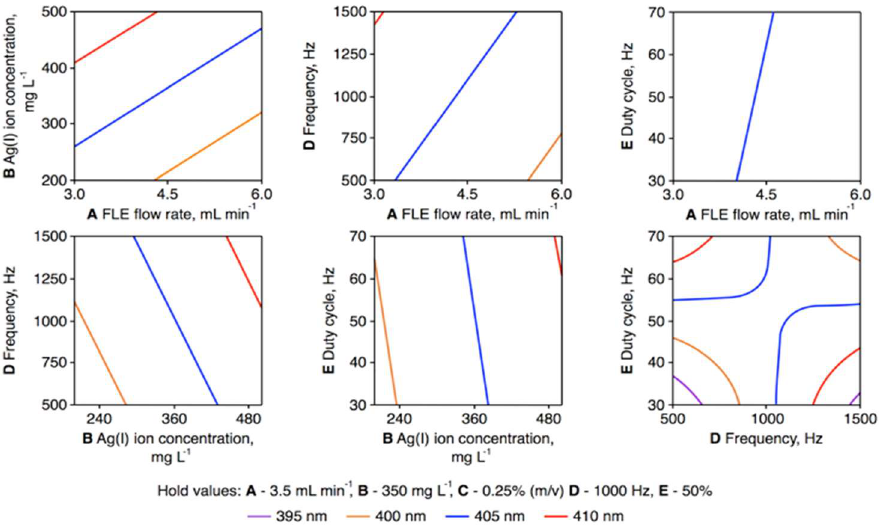
Figure 4. Counter plots of the wavelength at maximum (λ max ) of the localized surface plasmon resonance (LSPR) band of silver nanoparticles (AgNPs) synthesized using the pulse-modulated radio-frequency atmospheric-pressure glow discharge (pm-rf-APGD) system for pairs of statistically significant parameters in the developed response surface regression model (A–B, A–D, A–E, B–D, B–E, and D–E) at defined hold values. A: the flow rate of the flowing liquid electrode (FLE) solution (mL min −1 ); B: the precursor concentration in the FLE solution (mg L −1 ); D: the frequency of pulse modulation of rf current (Hz); E: the duty cycle (%).